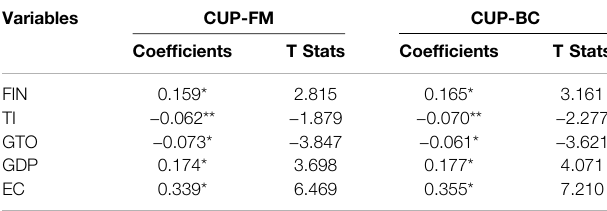
TABLE 6 | Long-run estimation results.